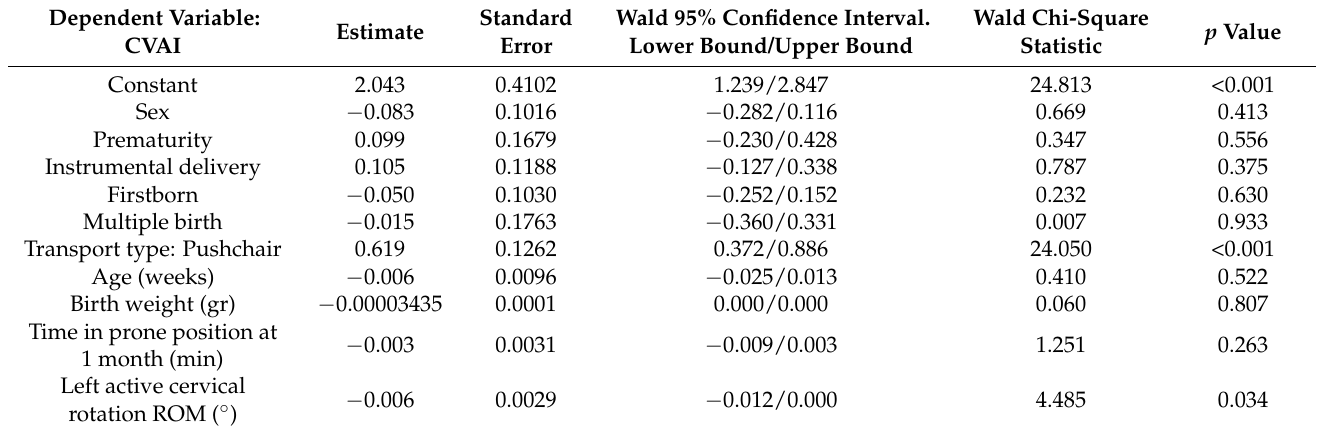
Table 4. Model effects with the left active cervical rotation ROM as a